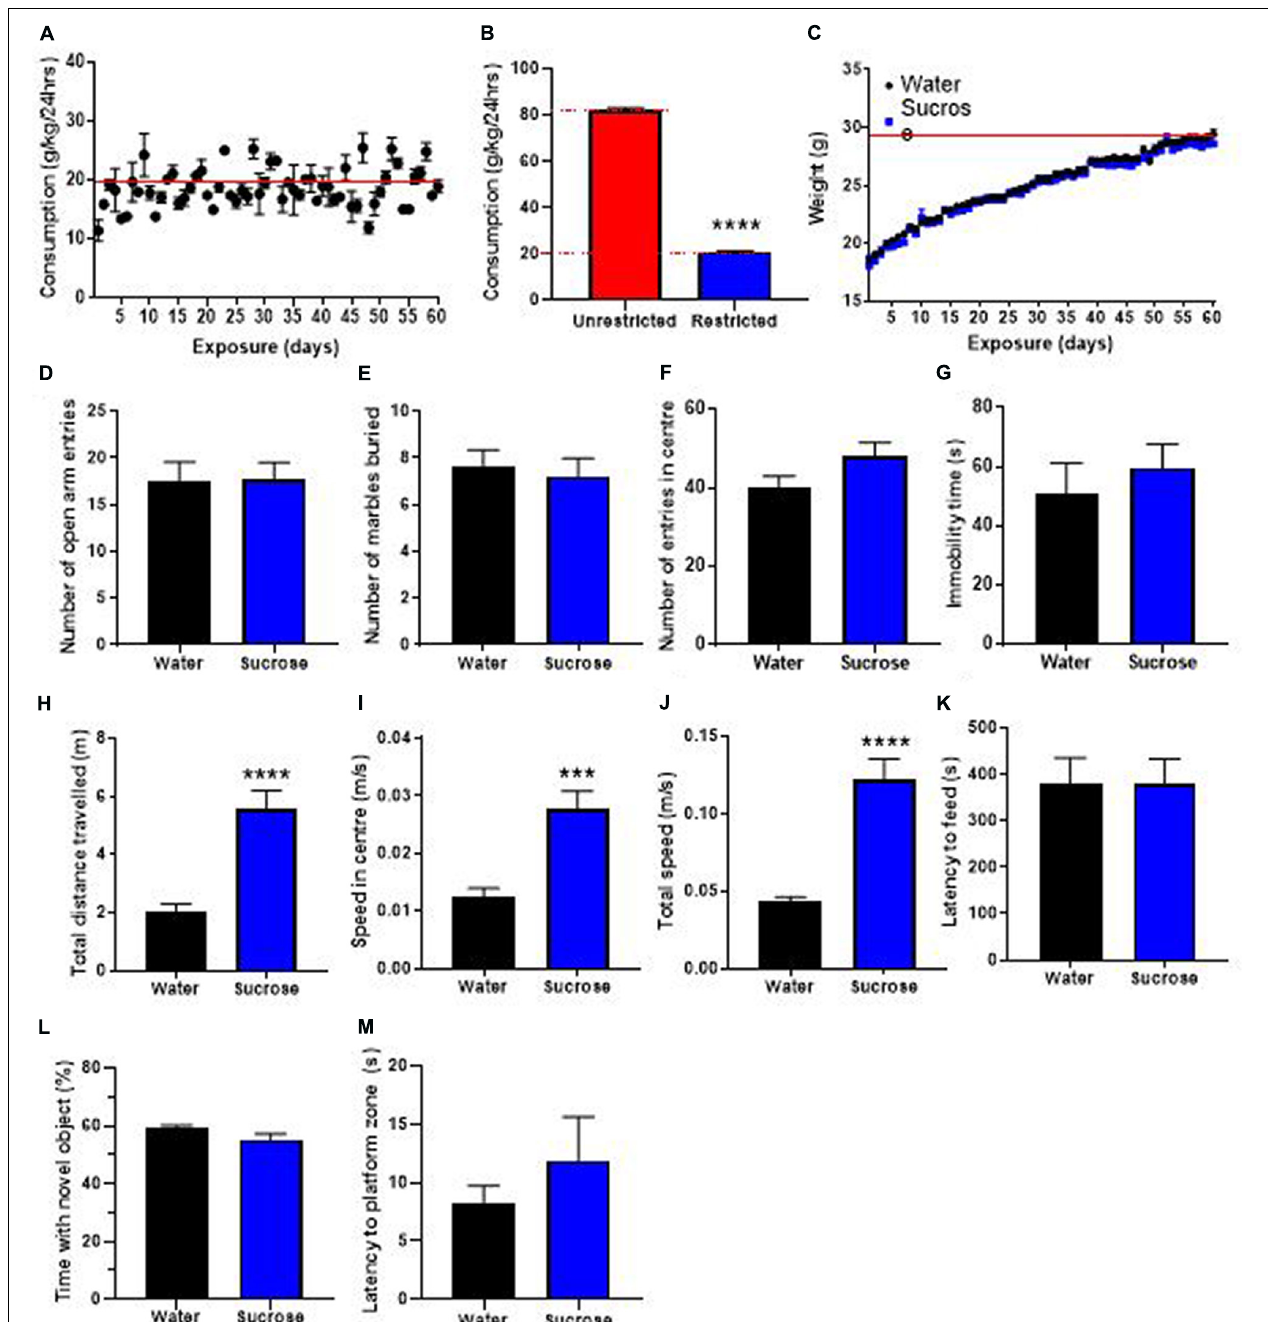
FIGURE 5 | Restricting access to sucrose consumption results in an absence of increased weight gain with no emotional and cognitive alterations. (A) Mice exhibit stable levels of long-term sucrose intake of 20.9 ± 0.3 g/kg indicated by the red line. This level of sucrose intake is four-fold lower than when sucrose access was unrestricted (B) and was not associated with any changes in weight gain (C) , or anxiety-related behavior as seen by no change in the number of entries in the open-arm of the EPM (D) , the number of marbles buried (E) and the number of entries in the center in the open field (F) compared to water controls. Restricting long-term sucrose consumption did not induce depressive-like symptoms as seen by no differences in the immobility time in the forced swimming test (G) compared to water controls. Restricted sucrose consumption increases the total distances traveled in the open field (H) , the speed in the center (I) and total speed (J) in the open-field, however, there was no change in the latency to feed (K) , the time spent with a novel object (L) and the latency to reach the zone where the platform was previously placed (M) , compared to water controls. Data are presented as mean ± SEM; n = 8 mice/group. *** p < 0.001, **** p < 0.0001.